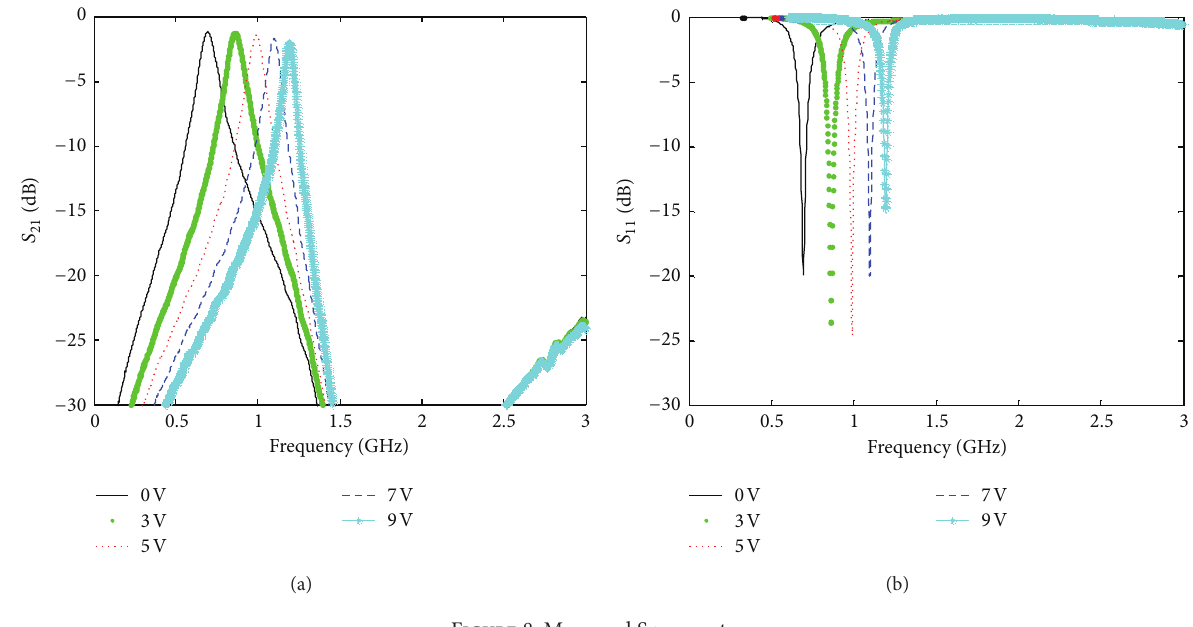
Figure 8: Measured 𝑆